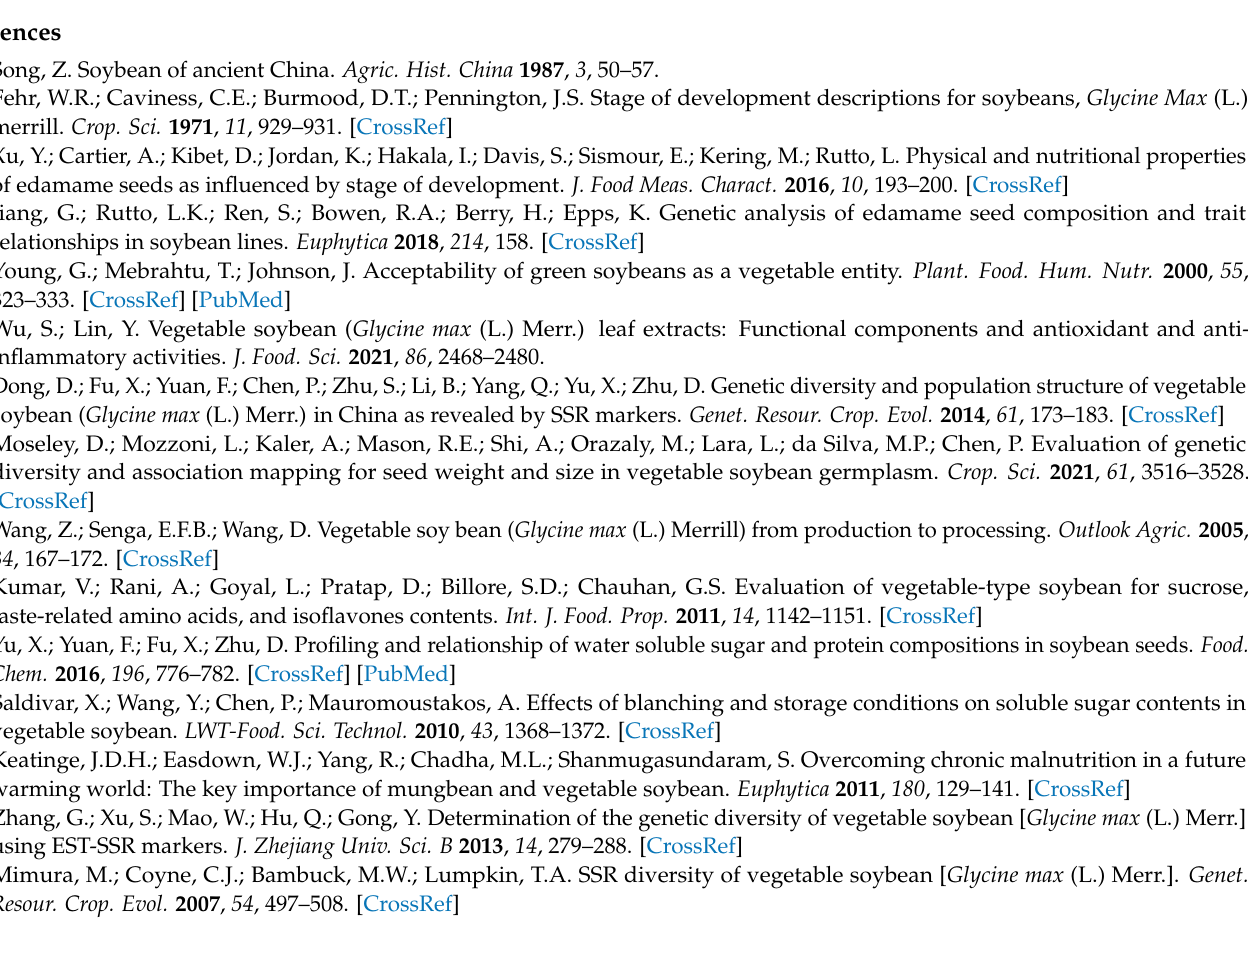
Figure S3: The distribution of the variation of Zhexian No. 10 on the